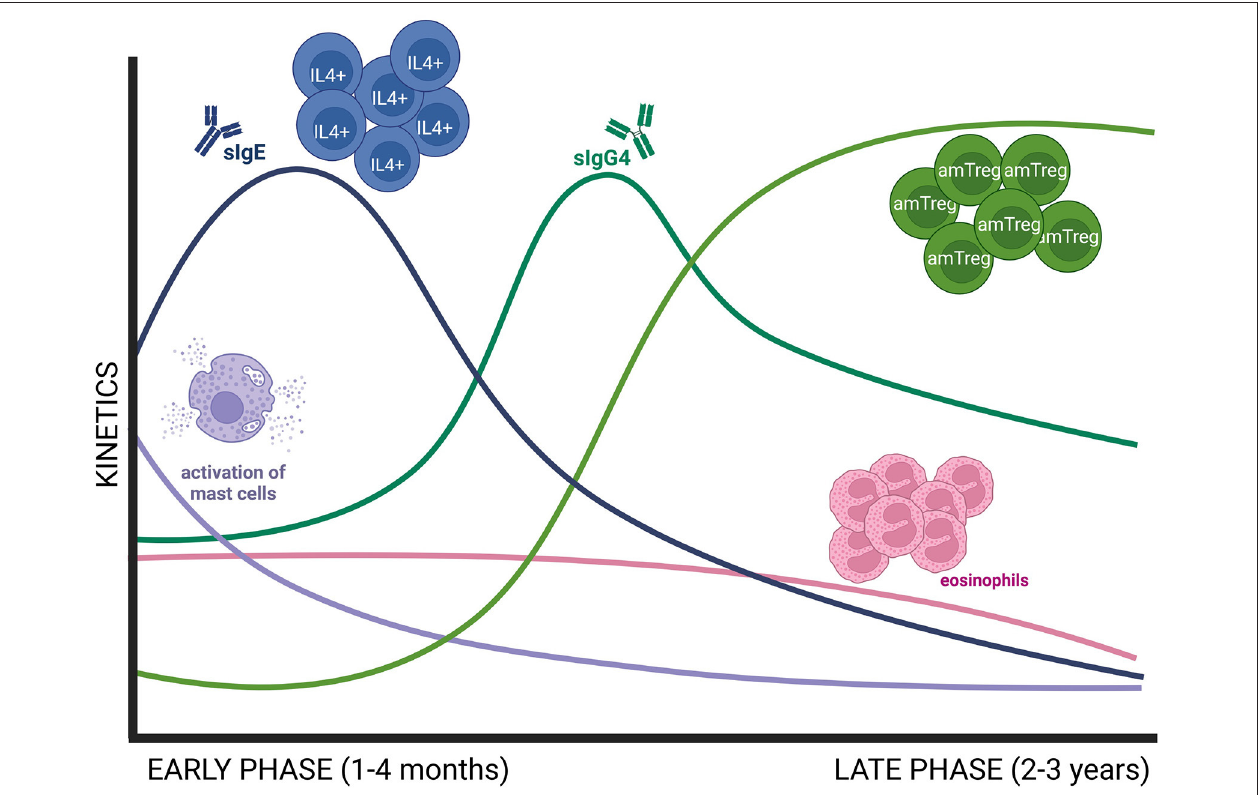
FIGURE 1 | Schematic representation of early and late immune changes associated to AIT. The early phase of AIT (1–4 months) is dominated by a decrease in MC activation, known as desensitization, and an initial invigoration of Th2 immunity, with increasing levels of allergen sIgE and IL4 + cells. Then, sIgE decreases while sIgG4 increases at the end of the early phase. Consolidation of AIT needs 2–3 years of treatment and is defined by an increase in Treg responses and a decrease in Th2 immune responses as well as in peripheral eosinophilia. amTreg, active memory Treg; MC, mast